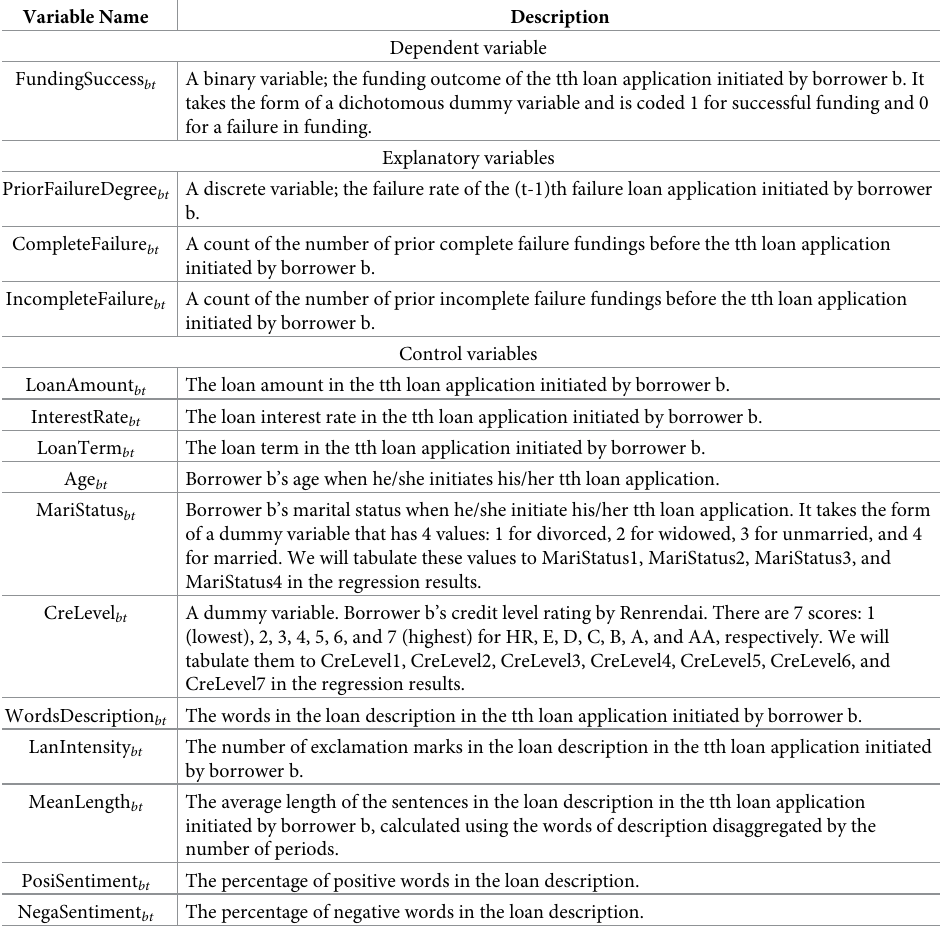
Table 2. Descriptions of the